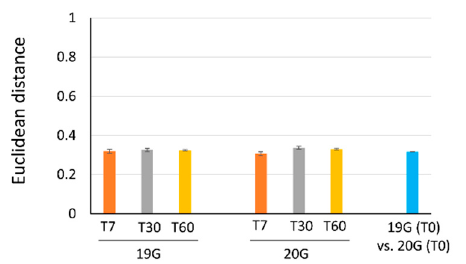
Figure 4. Bar plots of the Euclidean distances of batch 19G and 20G NMR spectra acquired at 700 MHz over time; the distances were calculated (i) between the spectra of both 19G and 20G obtained at each time point and the respective spectrum at T0 (T7 vs. T0: orange bars; T30 vs. T0: gray bars; T60 vs. T0: yellow bars) and (ii) between the T0 spectra of 19G and 20G (blue bars). A larger distance value indicates low similarity between the compared spectra.